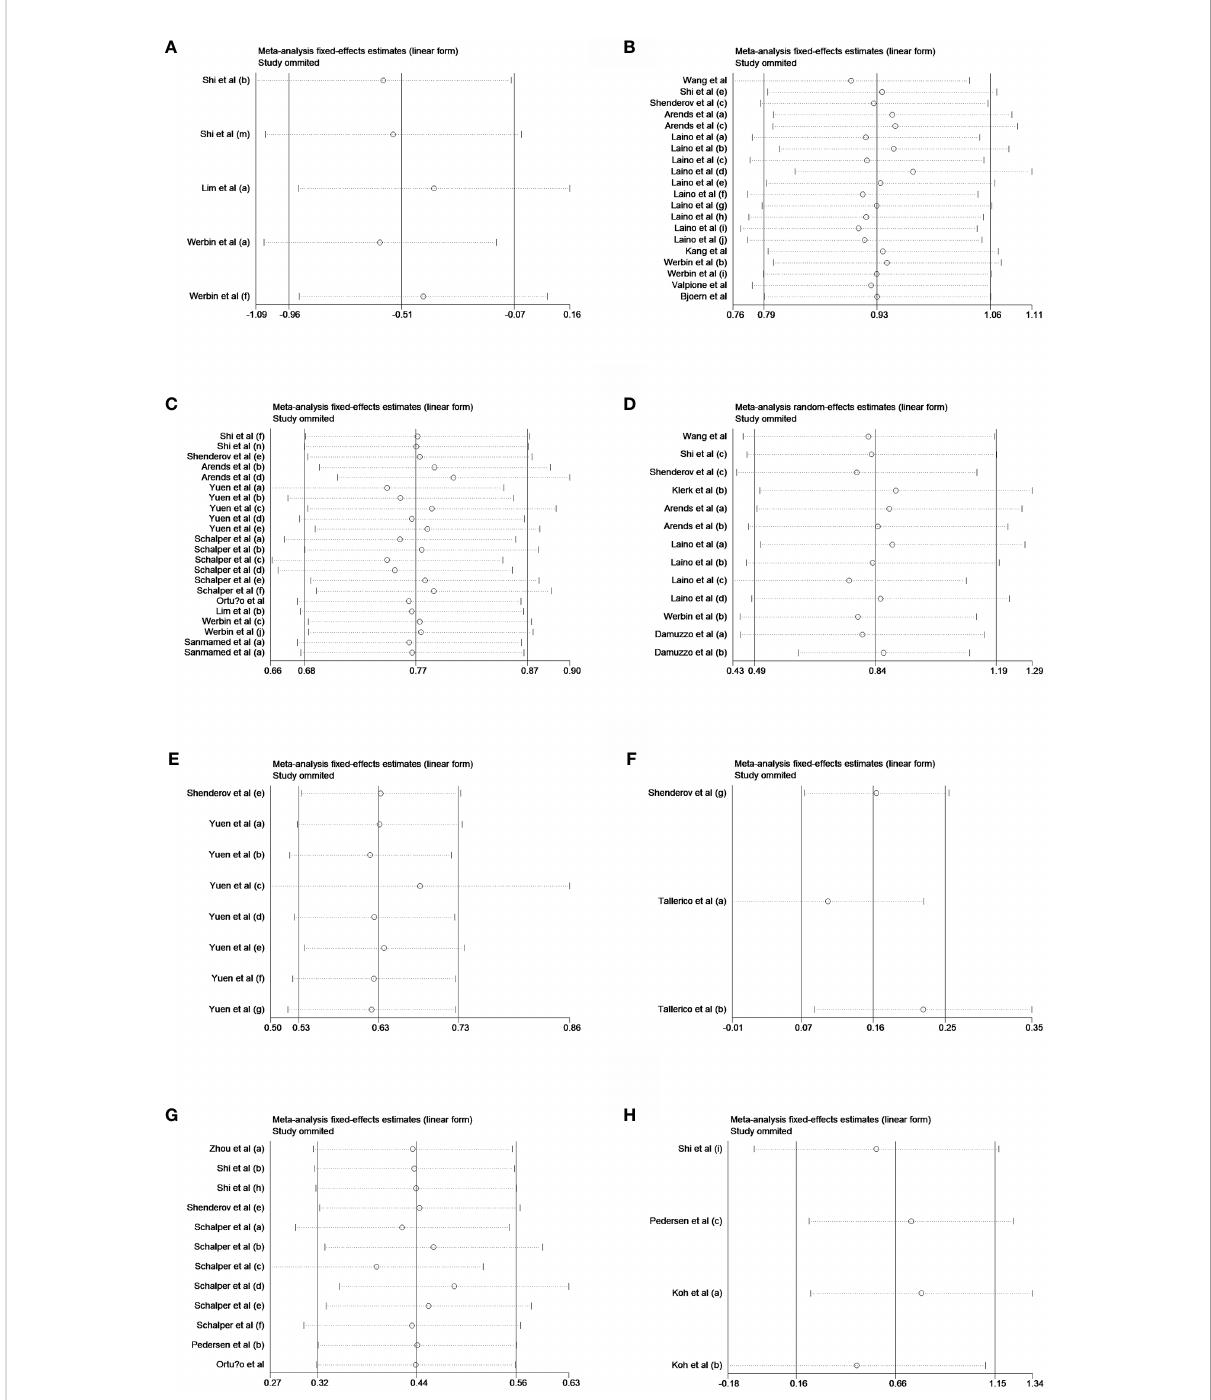
FIGURE 5 Sensitivity analyses of peripheral (A) IL-2, (B) IL-6, and (C) IL-8 in univariate analysis of OS and (D) IL-6, (E) IL-8, and (F) IL-15 in multivariable analysis of OS and (G) IL-8 and (H) IL-10 in univariate analysis of